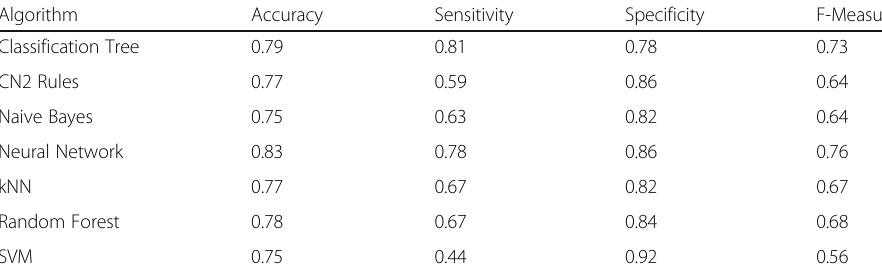
Table 6 Data Transformation: Equal Width, Feature Selection: None